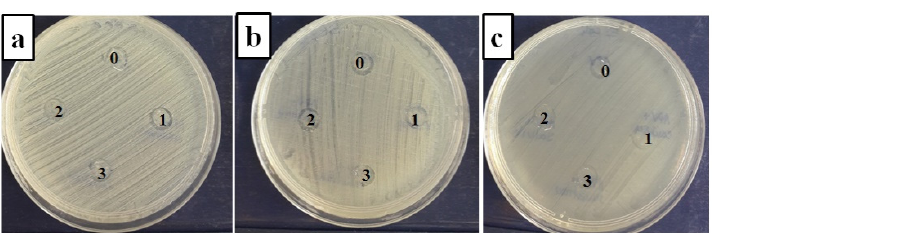
Figure 6. PVA electrospun membranes in contact with Staphylococcus aureus ATCC 25923 ( a ), MRSA ATCC 33591 ( b ), and E. coli ATCC 25922 ( c ). 0, PVA ; 1, PVA–Thymus vulgaris; 2, PVA–Salvia officinalis folium; 3, PVA–Hyperici herba.